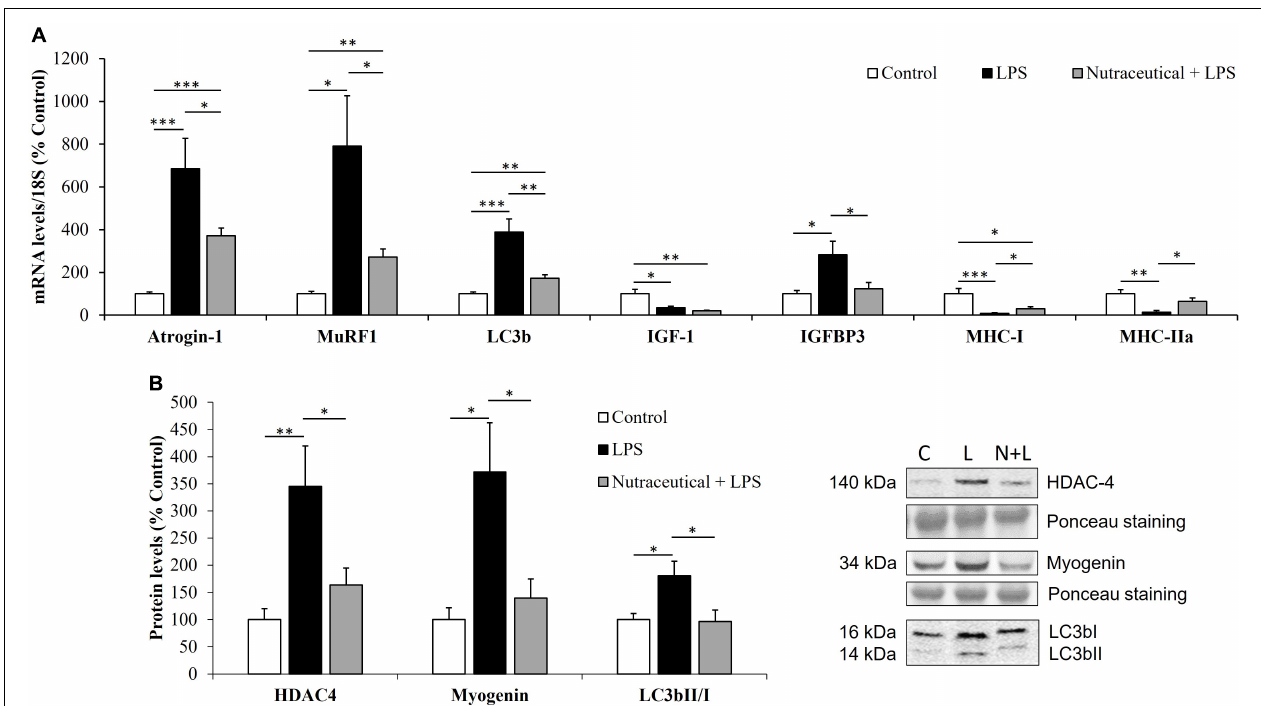
FIGURE 6 | mRNA concentrations of Atrogin-1, Muscle RING-finger protein-1, Microtubule-associated proteins 1A/1B light chain 3B, Insulin growth factor 1, IGF binding protein 3 and Myosin heavy chain isoforms I and IIa (A) and protein levels of Histone deacetylase 4, Myogenin and LC3bII/I ratio (B) in the gastrocnemius of rats treated with vehicle, LPS or LPS + Nutraceutical. Values are represented as mean ± SEM. ∗ p < 0.05; ∗∗ p < 0.01; ∗∗∗ p < 0.001. C, Control; L, LPS; N + L, Nutraceutical + LPS.